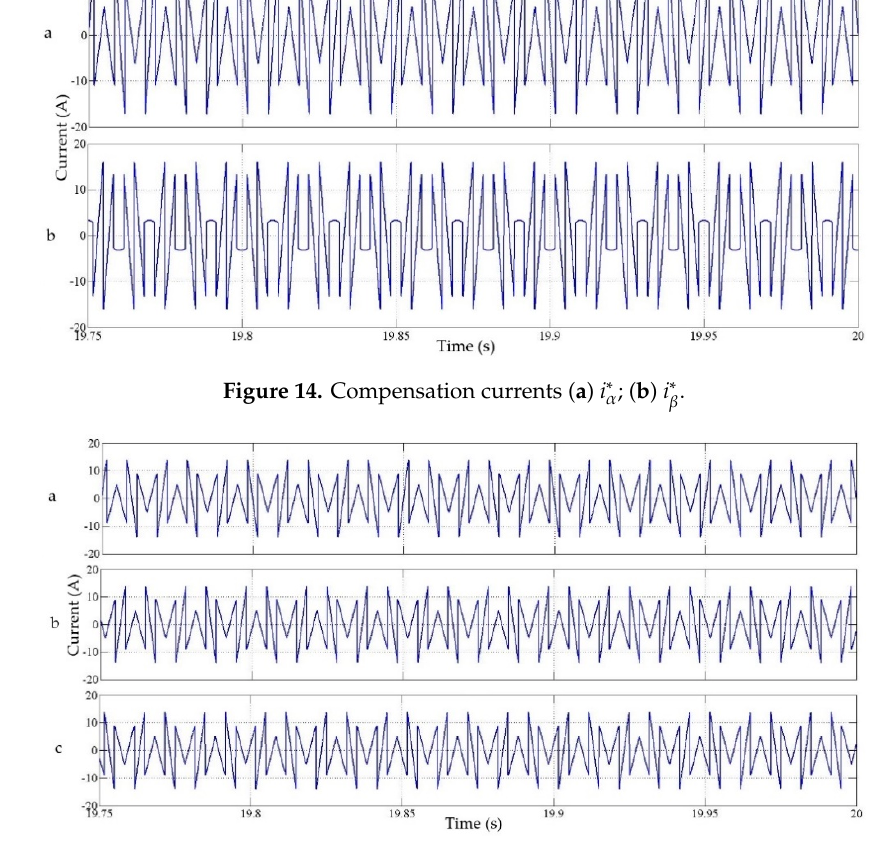
Figure 15. Transformed reference currents ( a ) (cid:1861) (cid:3028)∗ ; ( b ) (cid:1861) (cid:3029)∗ ; ( c ) (cid:1861) (cid:3030)∗ . Figure 11. Transformed voltages ( a ) 𝑣 𝛼 ; ( b ) 𝑣 𝛽 .